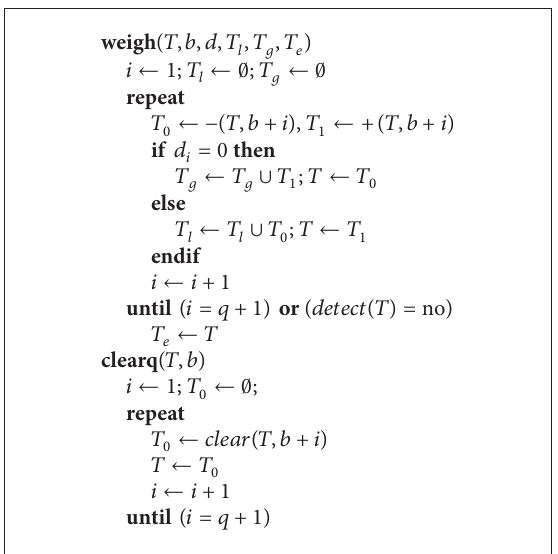
Algorithm 1: Algorithms of weigh and clearq